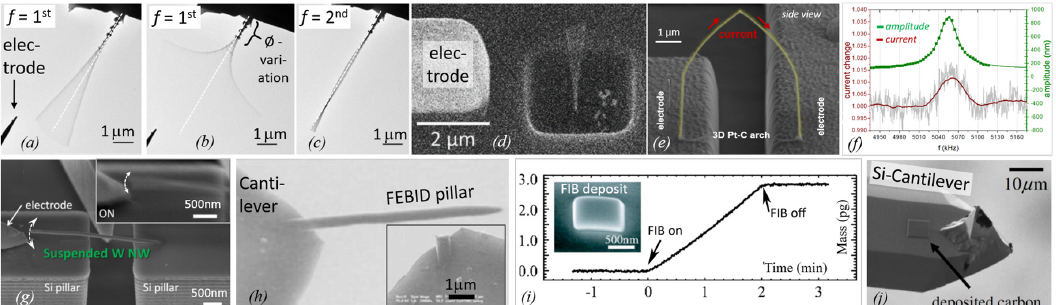
Figure 9. Selected overview of published methods for the density determination of nanostructures grown by FEBID and FIBID. ( a – c ) Pt-C FEBID pillar vibration with electric AC excitation inside a TEM. The first (a and b) and second fundamental resonances (c) can be seen. Note the large amplitude that the pillar can withstand as well as the diameter Ø variations. Modified from Hao et al. [90]. ( d ) SEM tilt view of an electrostatically AC excited Pt-C FEBID pillar vibration with integrated electrode design, modified from Arnold et al. [47]. ( e ) FEBID Pt-C bridge, which monitors vibrations in situ via the current read out shown in ( f ) modified from Arnold et al. [47]. ( g ) SEM tilt view of a laterally FIB grown pillar from W(CO) 6 with integrated electrode. The inset shows the fundamental resonance. Modified from Cordoba et al. [51]. ( h ) Destructive mass measurements of FEBID pillars grown on a cantilever. Modified from Utke et al. [55]. (i) In situ mass measurement of a Pt-FIBID deposit deposited on an SEM integrated cantilever with piezoresistive frequency readout. Modified from Friedli et al. [46]. ( j ) Mass measurement of Ga-FIB grown carbon structure. The cantilever frequency was measured before and after the deposition. Modified from Kometani et al. [38] .